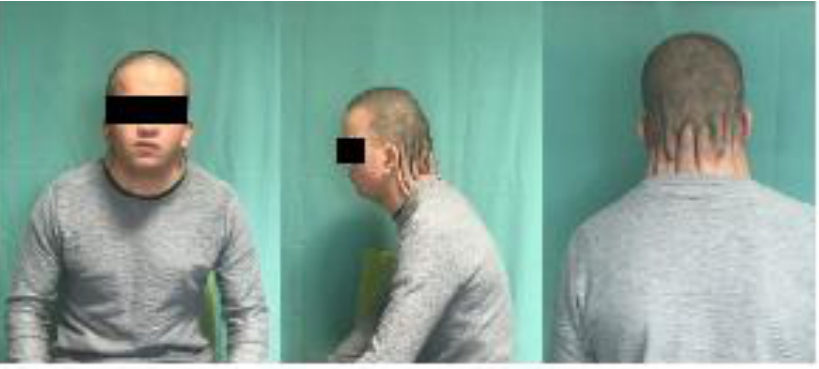
Figure 1. A 23-year-old man with pterygium colli associated with Noonan syndrome. The drawings were made pre-operatively, on a seated and awake patient. A horizontal mid-auricular line was drawn in the hairline area, as well as a vertical midline. Then a triangle with an upper base was drawn with a pinch test, representing the skin resection. The result is in fact the drawing of an “A-T” flap (Figure 2).